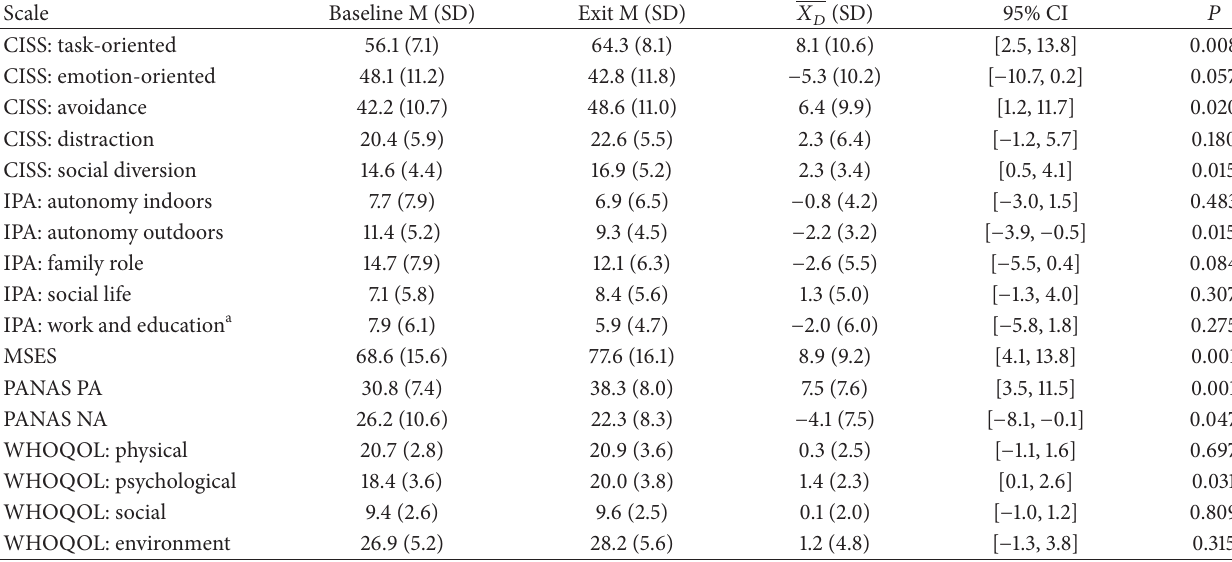
Table 2: CROP scores: baseline and exit ( n =